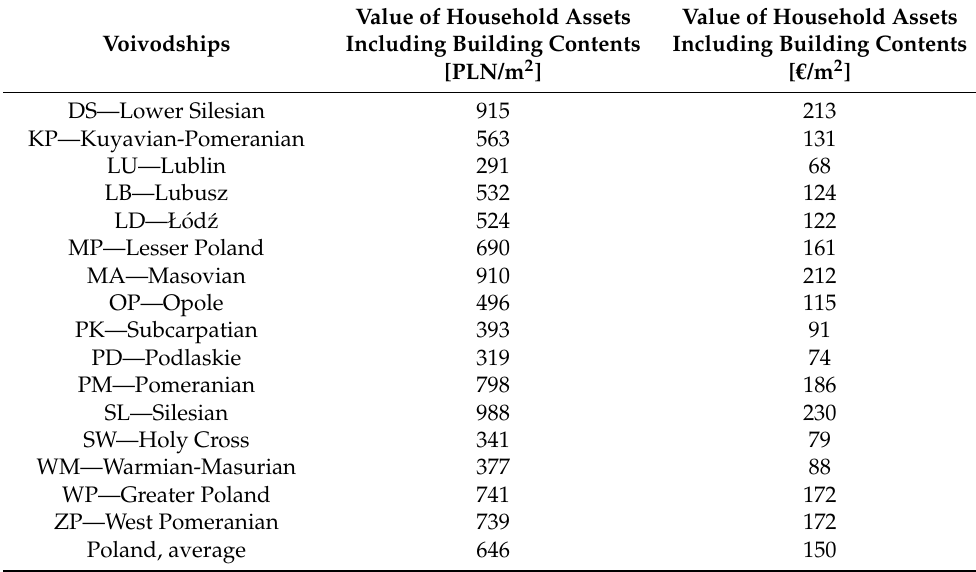
Table 2. Value of household assets, including building contents, in 16 voivodships (in 2019 prices). Value of Household